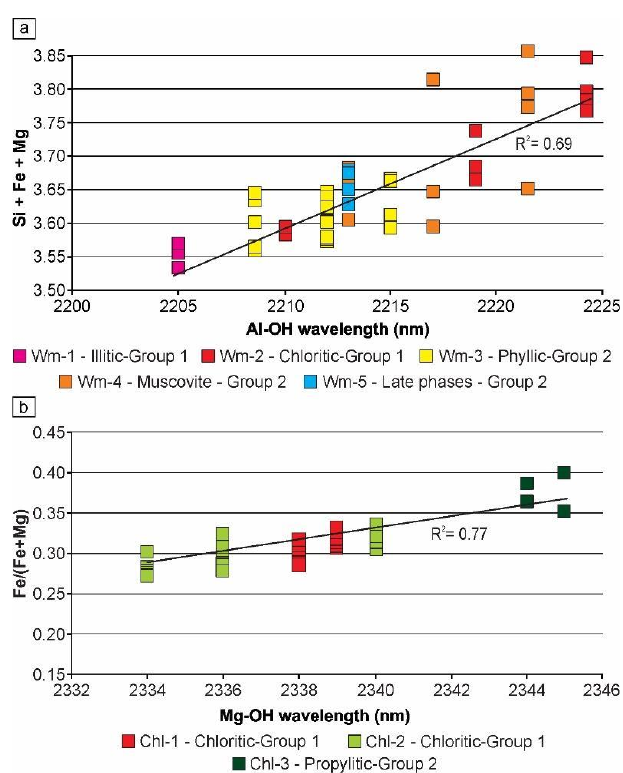
Figure 10. Scatterplots showing white mica and chlorite principal absorption wavelengths versus EPMA-derived cation contents. ( a ) Al-OH wavelength vs. Si+(Fe + Mg) of white mica; ( b ) Mg-OH wavelength vs. Fe/(Fe+Mg) of chlorite (from EPMA data, for 14 oxygen atoms). Spectral data were collected using the SisuCHEMA sensor with 30 μm pixel size in the same sectors where the EMPA measurements were carried out.